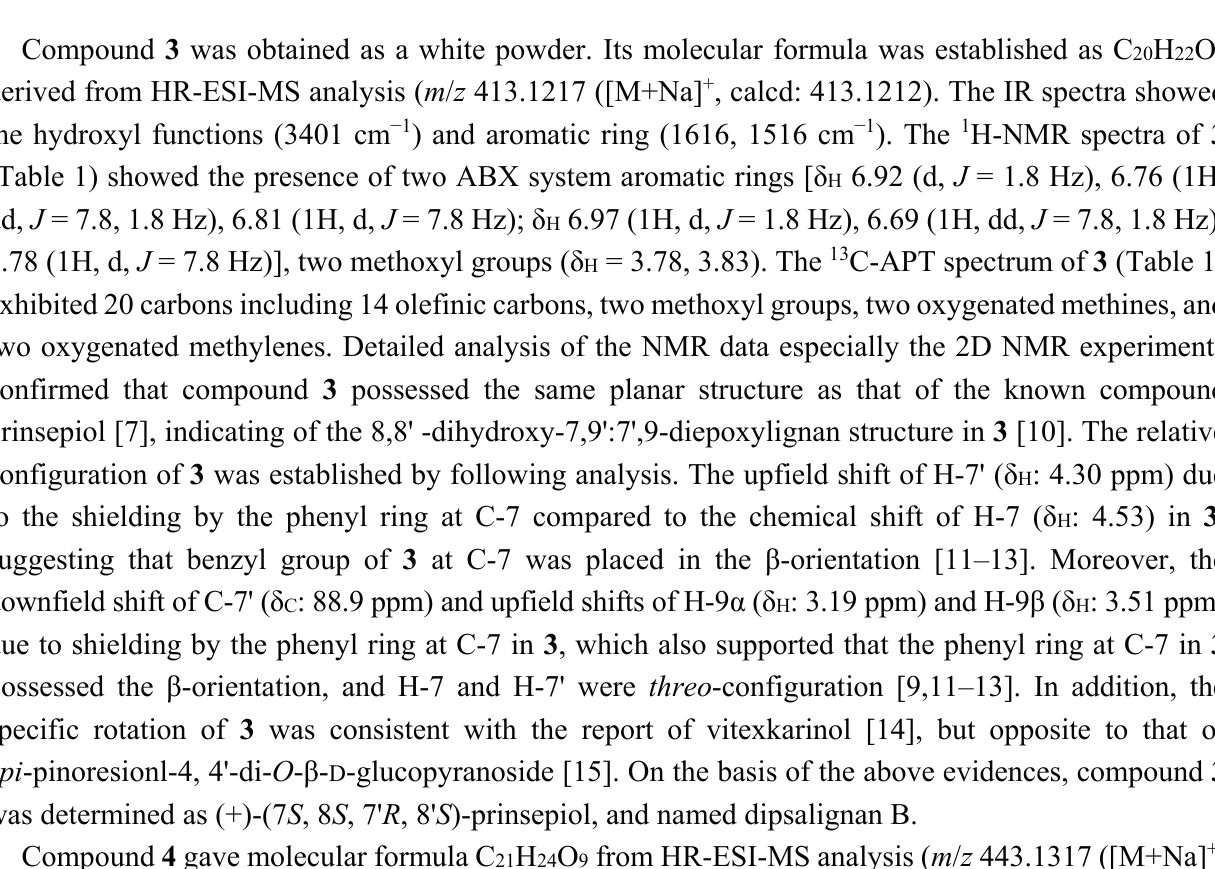
Figure 2. The key HMBC correlations of Compounds 1 and 7